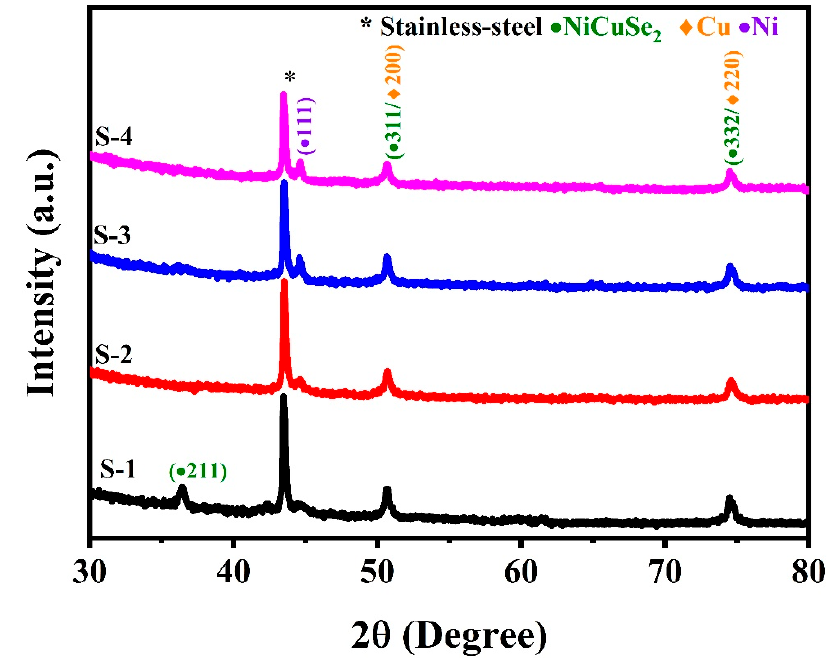
Figure 1. XRD patterns of all samples.